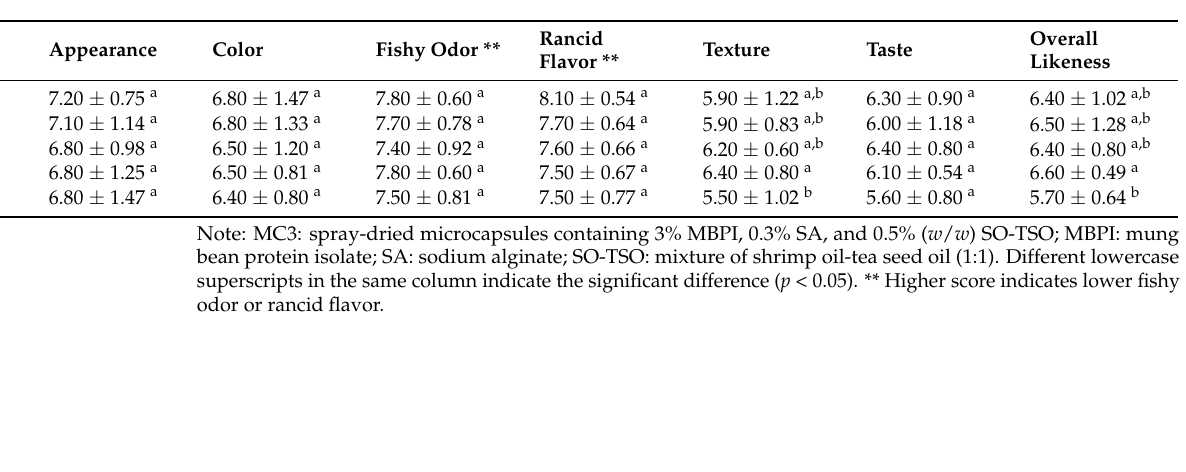
Table 4. Likeness scores of whole wheat crackers fortified with MC3 at different